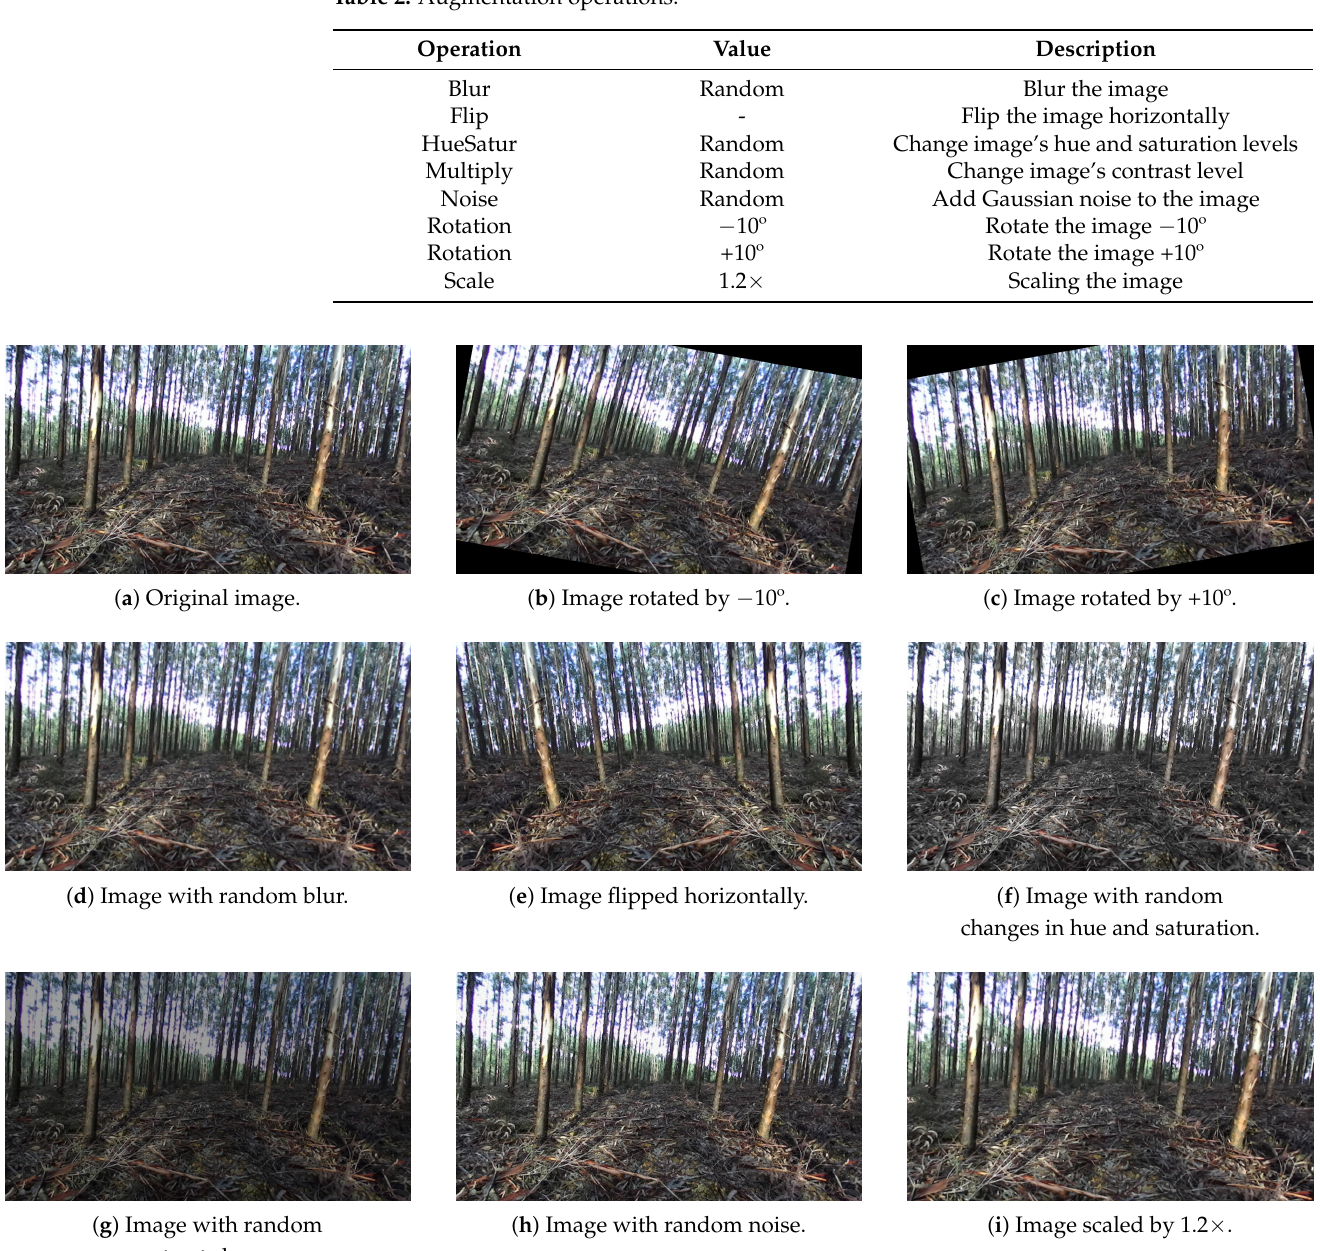
Figure 3. Augmentation operations in one image: ( a ) original image, ( b ) − 10º rotation, ( c ) +10º rotation, ( d ) random blur, ( e ) horizontal flip, ( f ) random hue and saturation changes, ( g ) random contrast changes, ( h ) random noise addition,